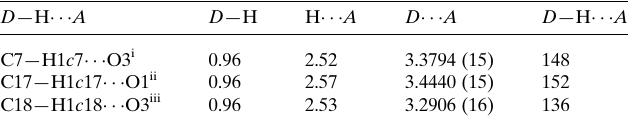
Table 1 Hydrogen-bond geometry (A˚ , (cid:2) ).